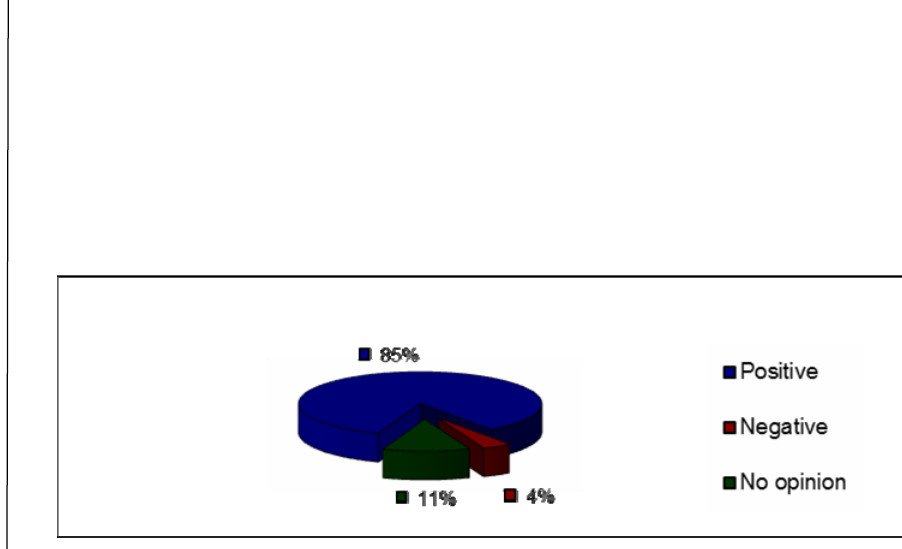
Figure 7 – Assessment of the termination of the work with explosive materials when the body fatigue is felt Рис . 7 – Оценка прекращения работы с взрывчатыми средствами , при выявлении слабости в организме